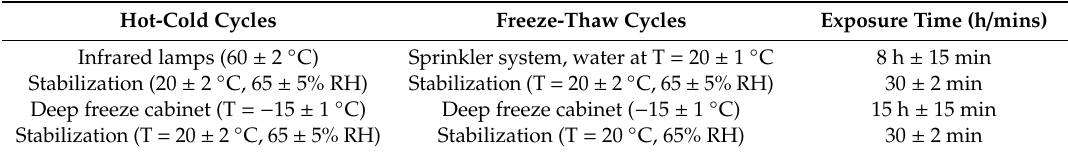
Table 3. Accelerated aging test: Hygrothermal cycles test